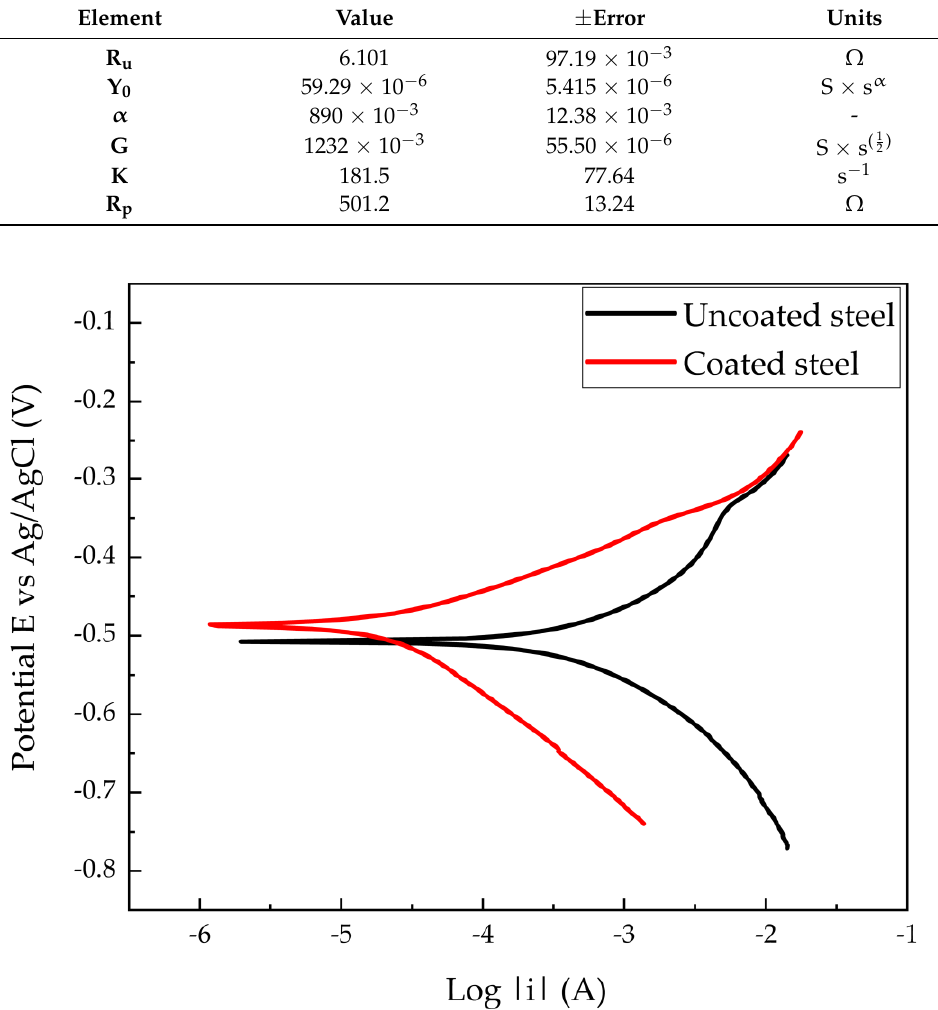
Figure 7. Potentiodynamic curves of mild steel in 0.1 mol L − 1 HCl with and without coating of Artemisia vulgaris